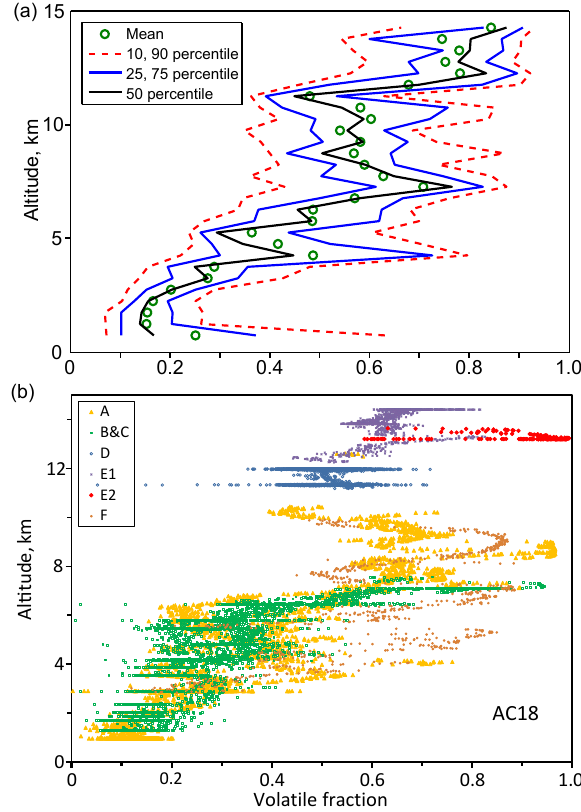
Figure 14. Volatile fraction. (a) Statistics from all flights; (b) indi- vidual segments from flight AC18 (see text for